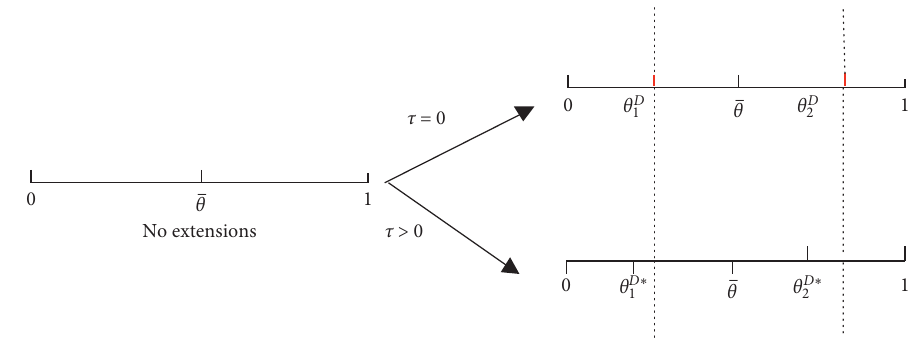
Figure 2: The distribution of consumers with a downward extension.